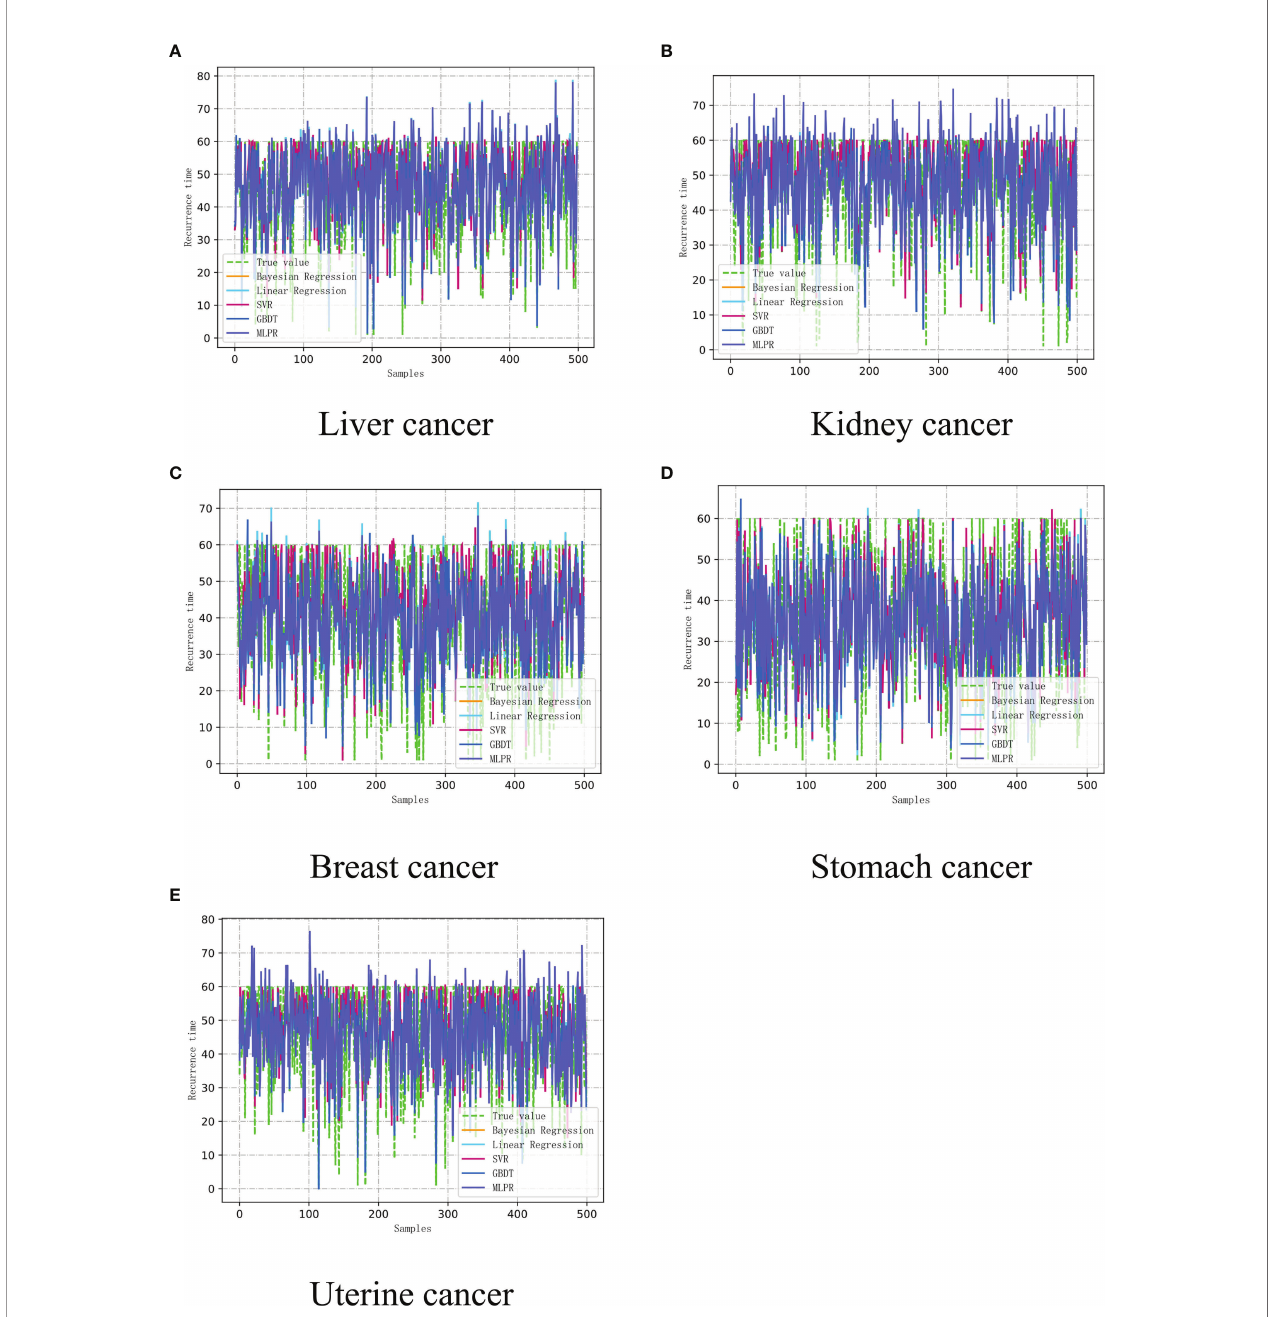
FIGURE 4 | The recurrence time model of cancer assisted diagnosis based on machine learning. (A) Liver cancer. (B) Kidney Cancer. (C) Breast cancer. (D) Stomach cancer. (E) Uterine